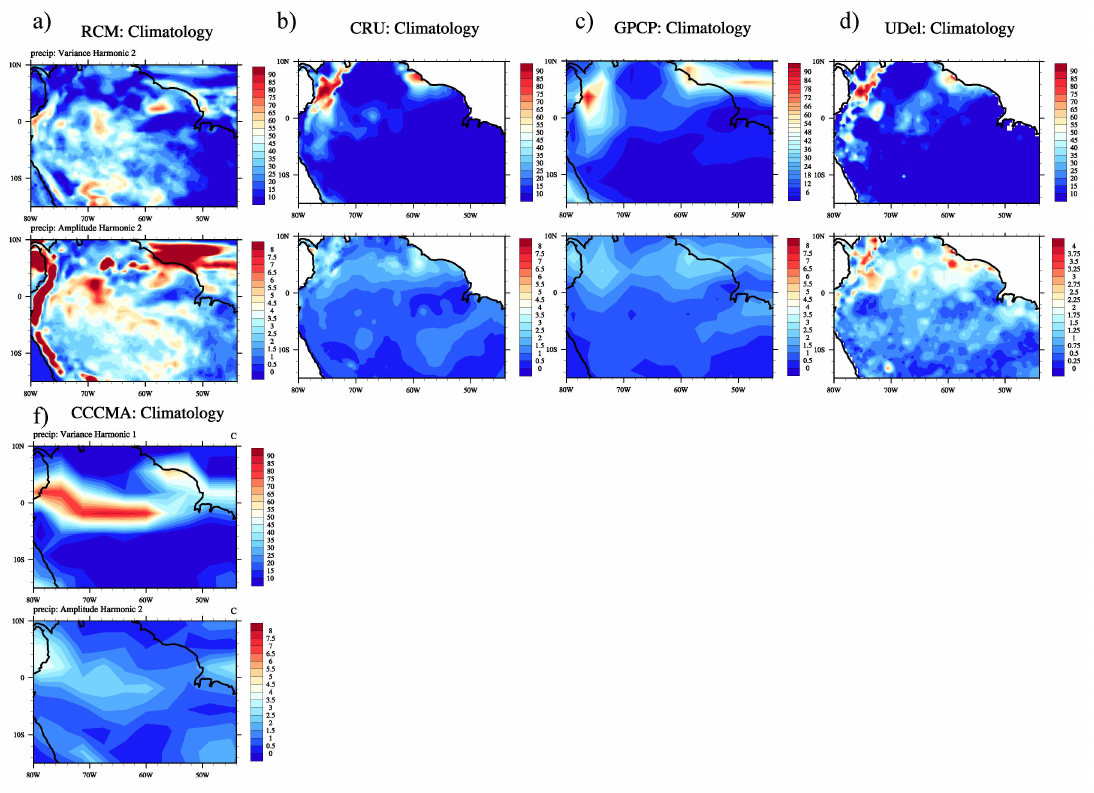
Figure 4. Same as Figure 3 but for precipitation (mm/month). ( a ) PD-RCM simulation ( b ) CRU, ( c ) GPCP, ( d ) UDel, and ( e ) the